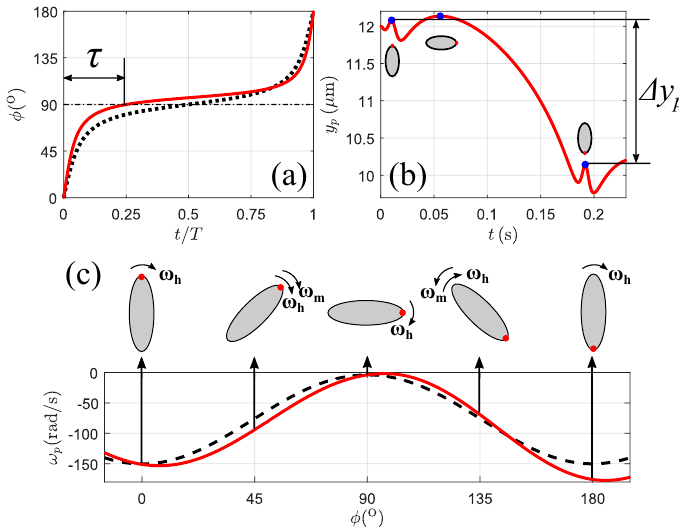
Figure 8. Transport of the particle when the magnetic field is applied parallel to the flow direction, i.e., α = 90 ◦ . The particle ( AR = 4) is initially located at y p 0 = 12 µ m. ( a ) φ varies with dimensionless time t / T ; ( b ) variation of the particle–wall separation distance with time, and ( c ) the total rotational velocity ω p varies with φ for H 0 = 0 A/m (dash line) and 3000 A/m (solid line).